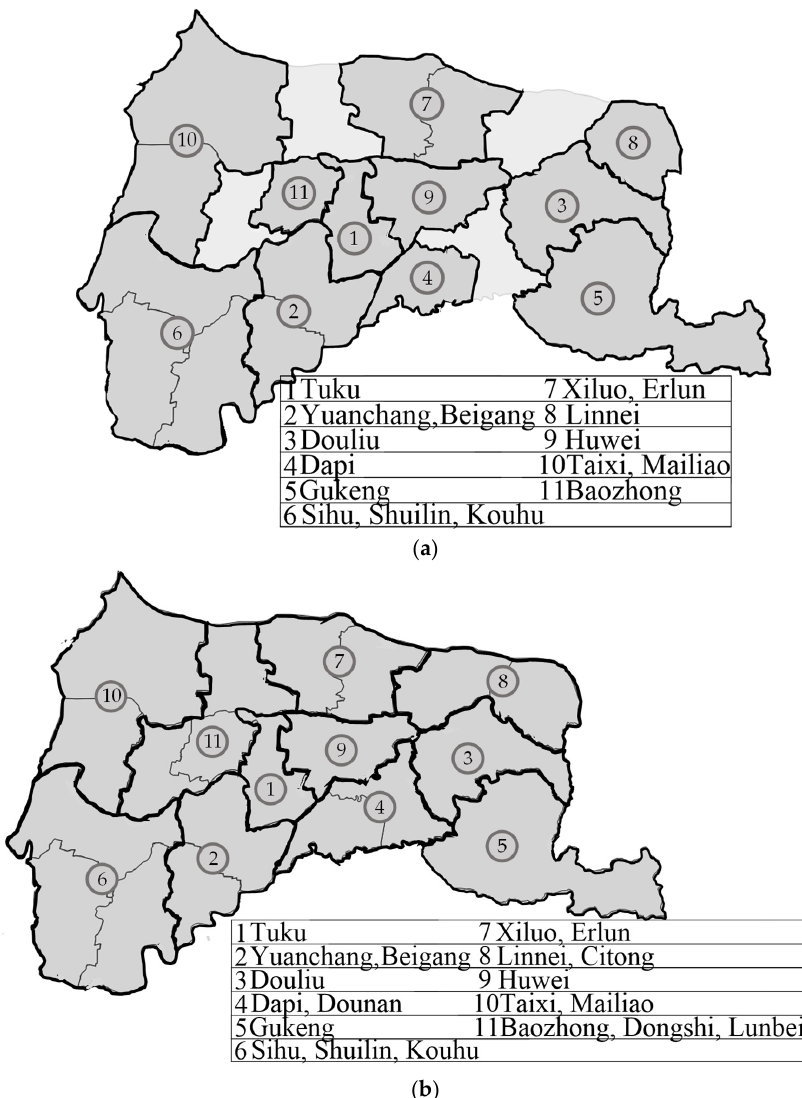
Figure 13. ( a ) Basic division of Yunlin County’s 20 administrative regions, with four administrative regions undetermined. ( b ) Final division of Yunlin County’s 20 administrative regions.